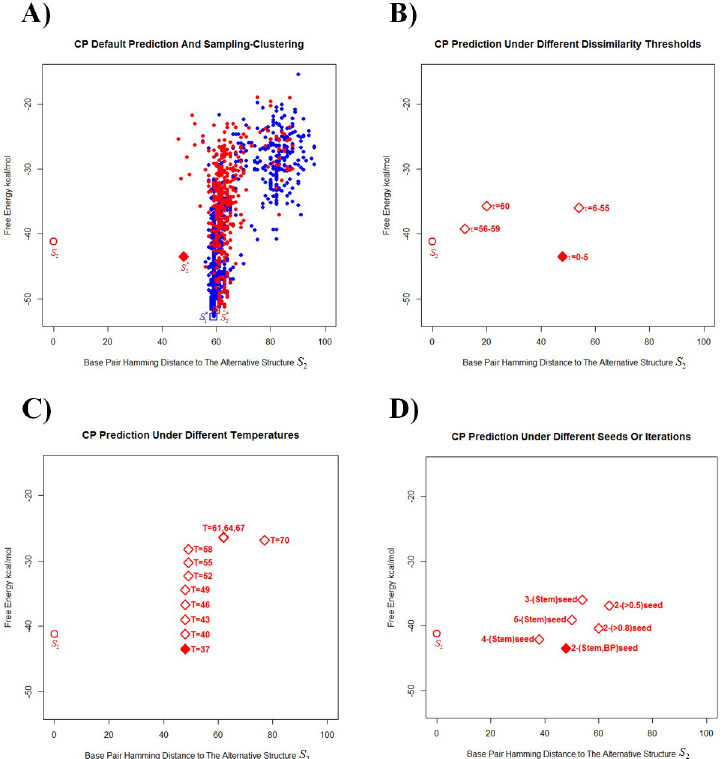
Fig 6. Alternative-Structure-Referenced (ASR) energy landscape of xpt Guanine riboswitch. The sequence length was 162nt, directly from the Barsacchi dataset. In each subfigure, the open red circle on the left represents S 2 . In Fig 5B–5D, the solid diamond represents CP prediction under default parameters; and the empty diamonds, CP prediction under non-default parameters. A) The solid red diamond represents the CP-predicted alternative structure S � ; and the 2 . Blue and red dots represent samples of the MFE-containing open red square, the SC-predicted alternative structure ^ S � 2 and alternative clusters, respectively (see Materials and methods for details on the Sampling-Clustering procedure). B) CP-predicted alternative structures S � under different dissimilarity thresholds τ = 0 ... 60. If predictions were identical, 2 under different they are shown with a label indicating a range for τ . C) CP-predicted alternative structures S � 2 temperatures T from 37˚C to approximate melting temperature 70˚C. The free energy of any fixed structure varies with temperature, and the underlying RNA structure remained fixed for temperatures 37 � T � 49, 50 � T � 58, and 61 � T � 67. D) CP-predicted alternative structures S � under different seeds and iterations. The initial number in the 2 label of each point gives the iteration i = 2 ... 5. The seed was either a stem seed L � , a base-pair seed (the base pair with highest conditional probability, denoted by “BP”), or all base pairs with conditional probability higher than a threshold (either 0.5 or 0.8). For iteration number i = 2, the CP-predicted S � from stem and base-pair seeds were identical: hence, 2 its label